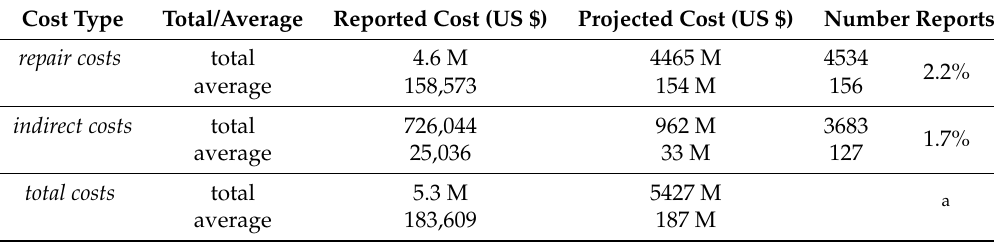
Table 3. Repair and indirect costs resulting from wildlife strikes in the US from 1990 to 2018